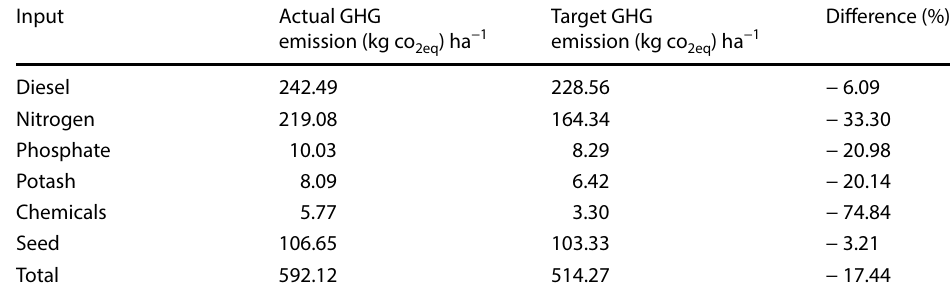
Table 5 GHG emissions based on present and